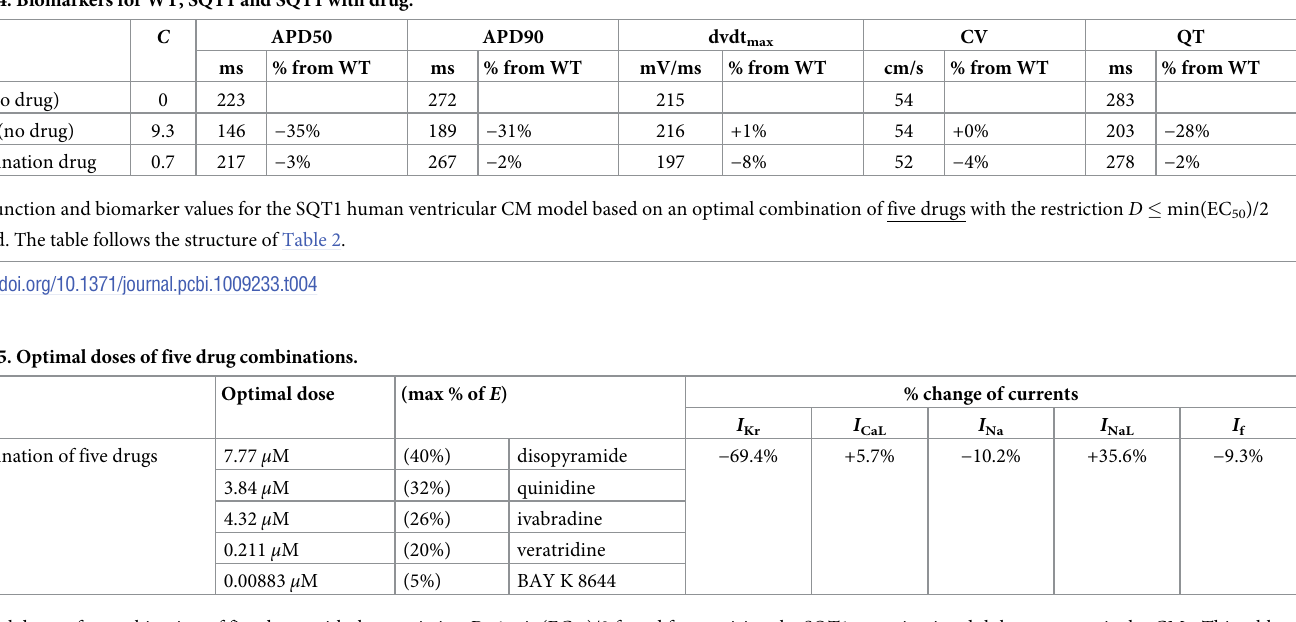
Table 4. Biomarkers for WT, SQT1 and SQT1 with drug.